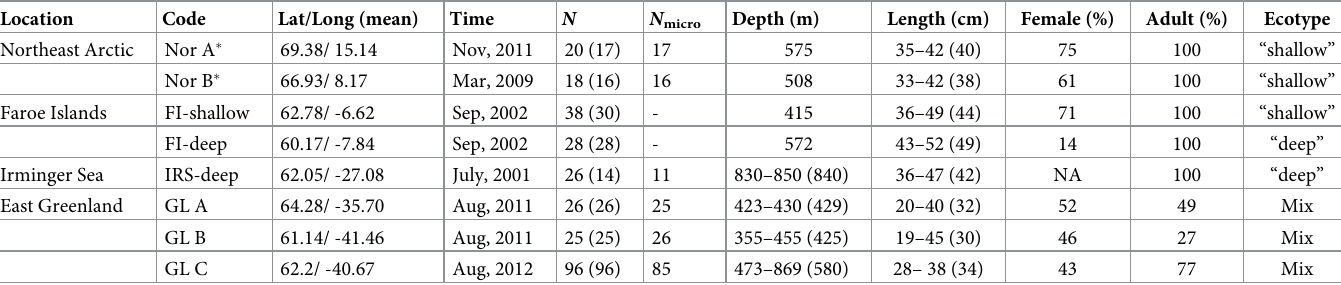
Table 1. Details of the S . mentella samples analyzed.